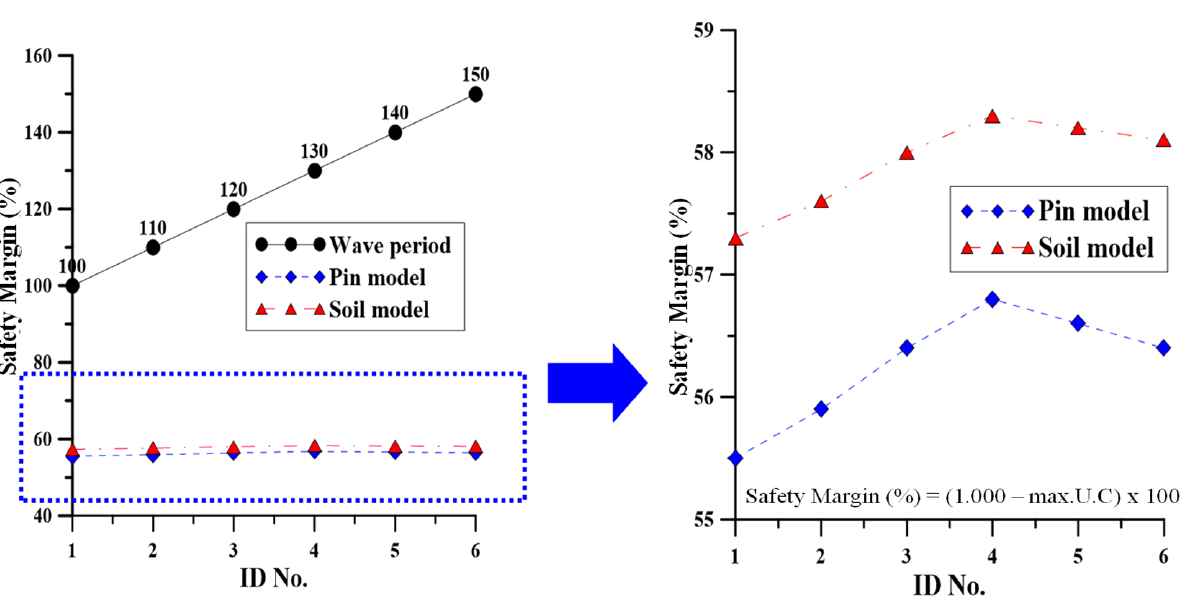
Figure 10. Comparative unit check margin with varying wave period.